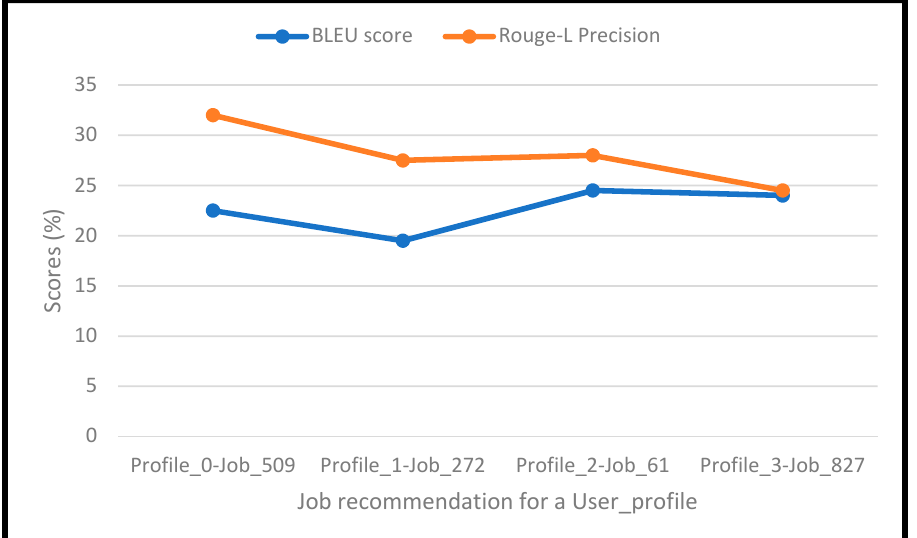
Figure 12. BLEU and Rouge-L scores for a sample of recommended job postings to two user profiles.